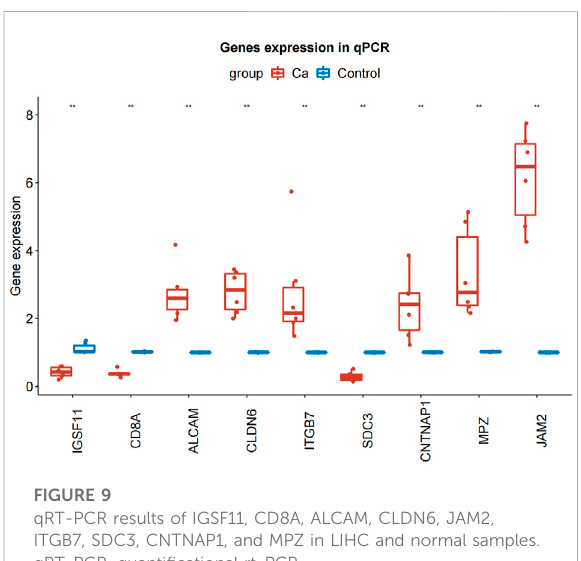
FIGURE 9 qRT-PCR results of IGSF11, CD8A, ALCAM, CLDN6, JAM2,